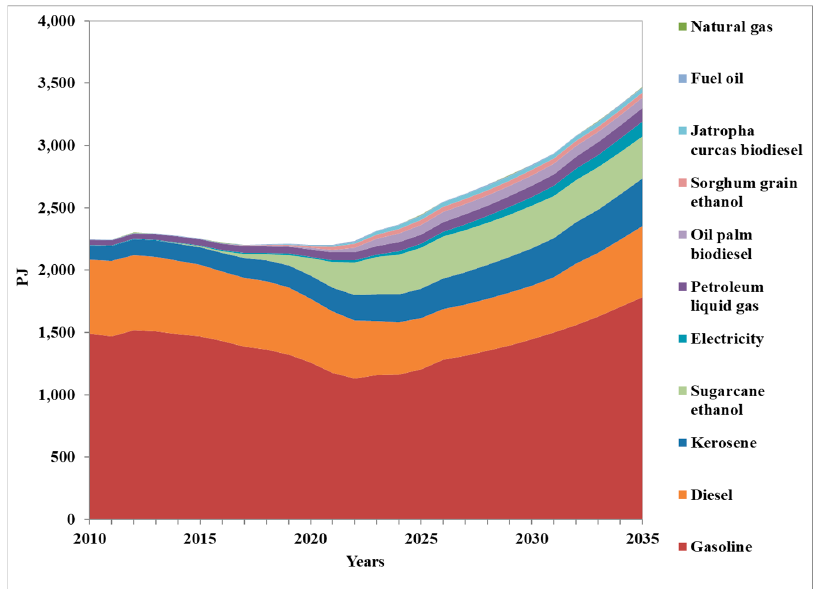
Figure 6. Energy consumption by energy carrier in the LCS.